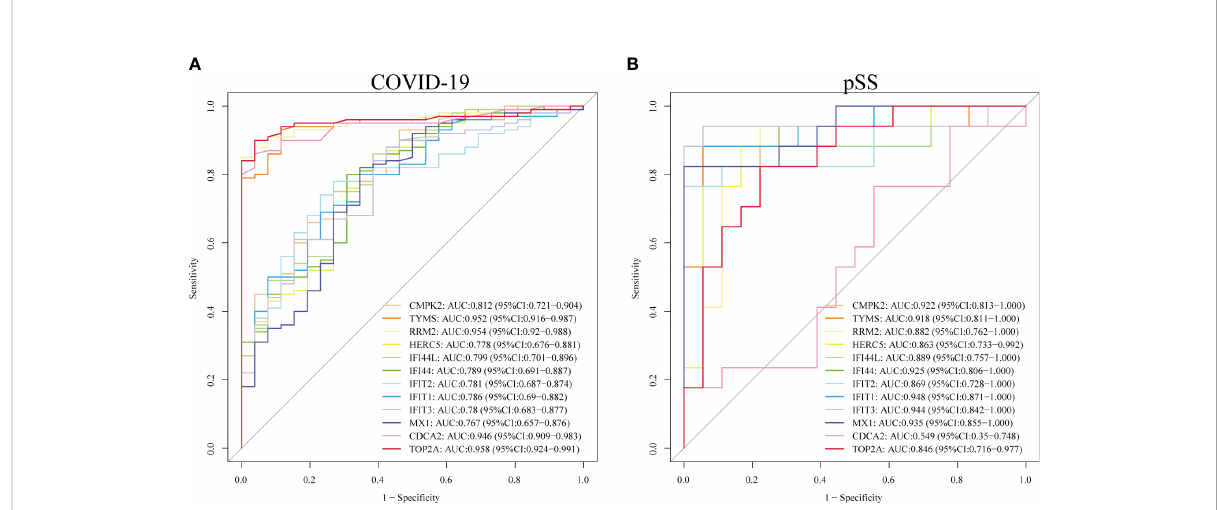
FIGURE 9 Validation of diagnostic shared biomarkers. (A) The ROC curve of the diagnostic ef fi cacy veri fi cation in GSE157103. (B) The ROC curve of the diagnostic ef fi cacy veri fi cation in